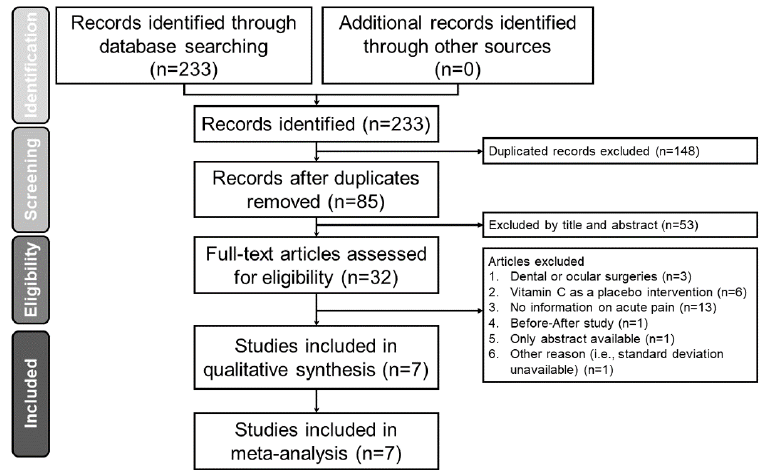
Figure 1. Preferred Reporting Items Systematic Reviews and Meta-Analysis (PRISMA) flowchart for selecting eligible studies.